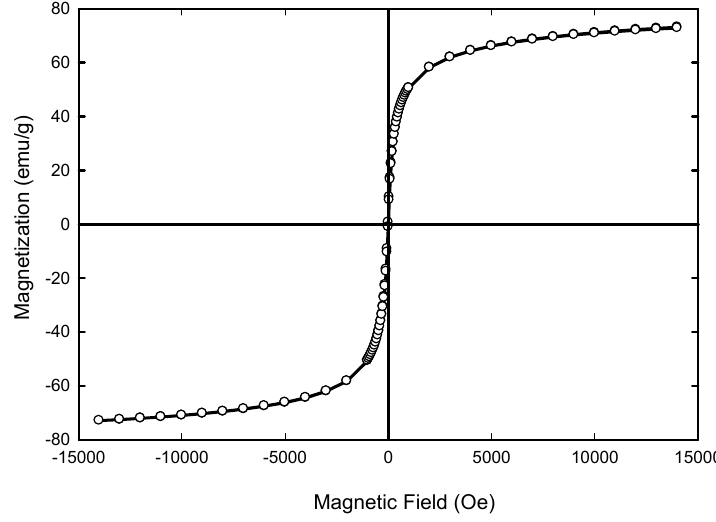
Figure 8. Magnetic hysteresis loop for the sample Fe 3 O 4 at 300 K.